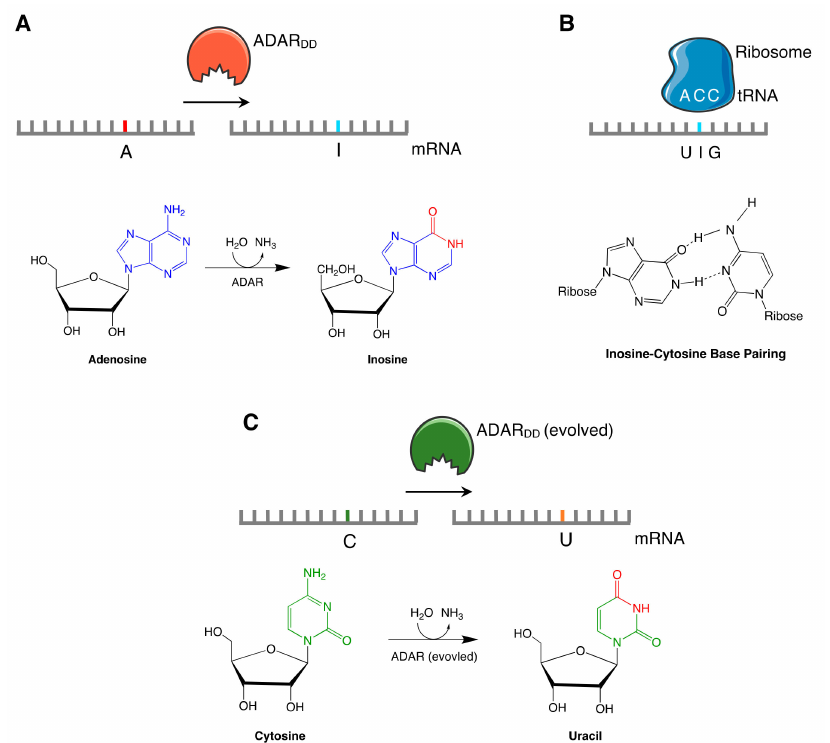
Figure 2. ( A ). Demonstrates the hydrolytic deamination of adenosine to inosine. ( B ) Base pairing between inosine and cytosine allow inosine to be read as a guanosine during translation by the ribosome, e ff ectively an A-G edit. ( C ). Evolved mutants of human ADAR allow for deamination of cytosine to uracil for C-U editing. ADAR = adenosine deaminase acting on RNA; DD = deaminase